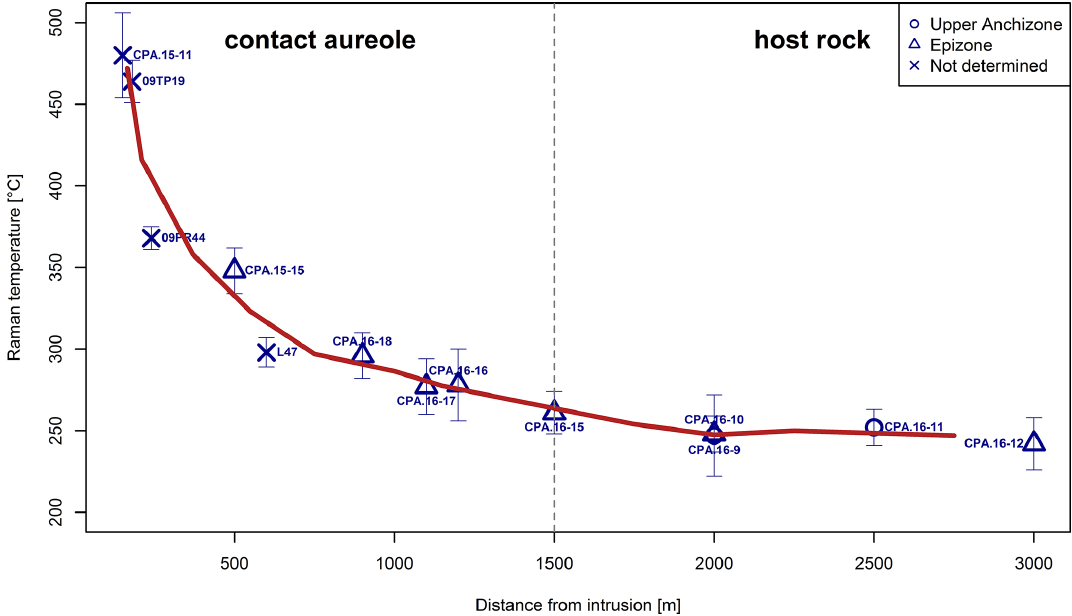
Figure 5. Temperatures obtained from carbonaceous matter as a function of distance towards the Torres del Paine intrusion. The red line indicates the moving average with a window size of